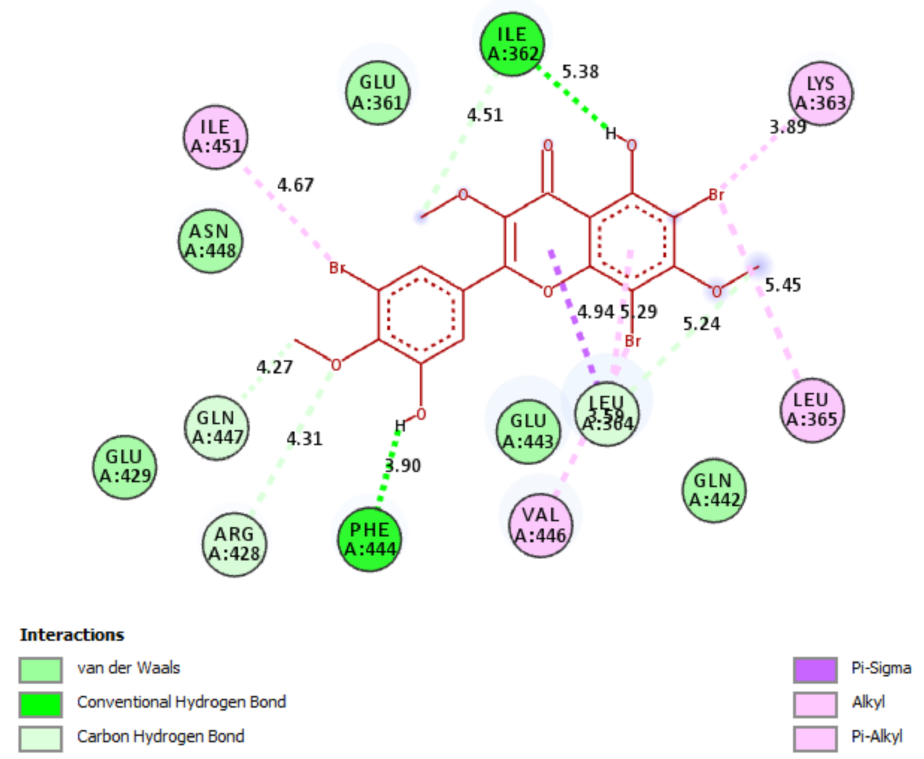
Figure 9. The most interactions were linked from pose 8 to amino acids on receptor 4J5T